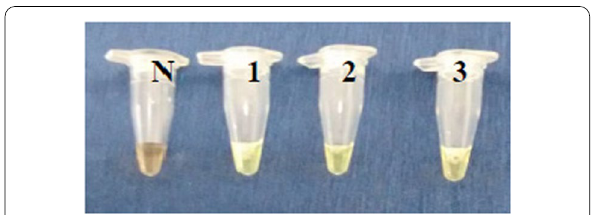
Fig. 2 Visualization of LAMP products. Tube N: known negative sample. Tube 1: known positive sample. Tubes 2–3: test samples